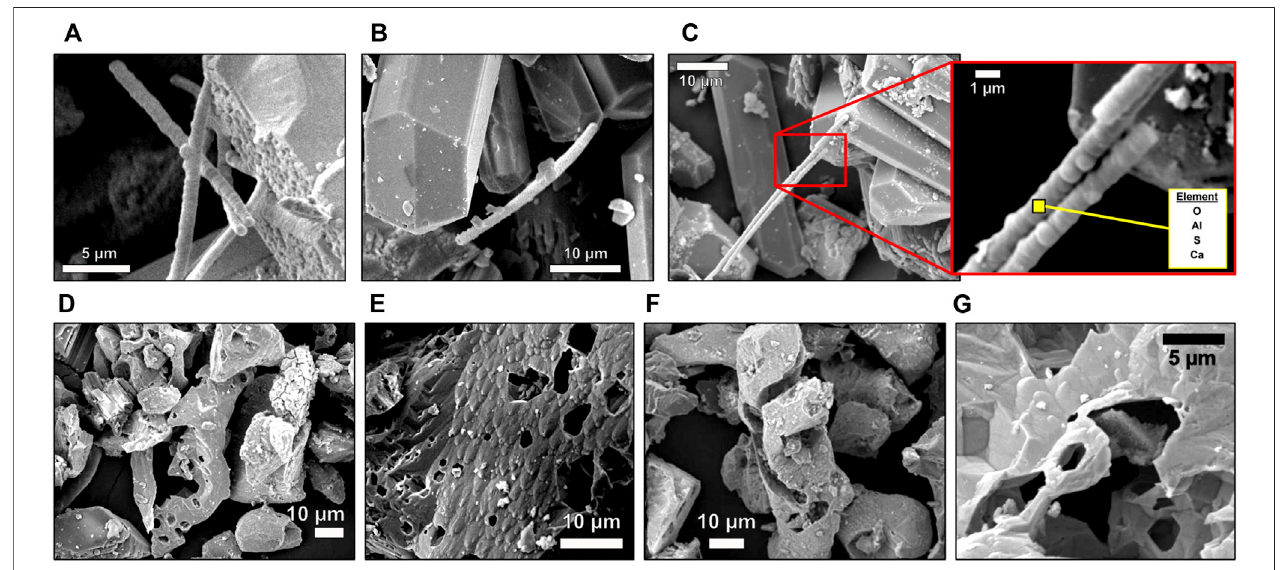
FIGURE 8 | SEM/EDS of Samples C2 and C4. Several encrusted fi lamentous structures were detected in sample C2 (A – C) . The red inset in (C) shows a higher magni fi cation image of two fi laments. A spectrum was collected at the spot in the yellow square and shows O, Al, S, and Ca (as well as the Au which was used as a coating). Grains of pyrite with polygonal etchings were observed throughout sample C4 (D – G) .